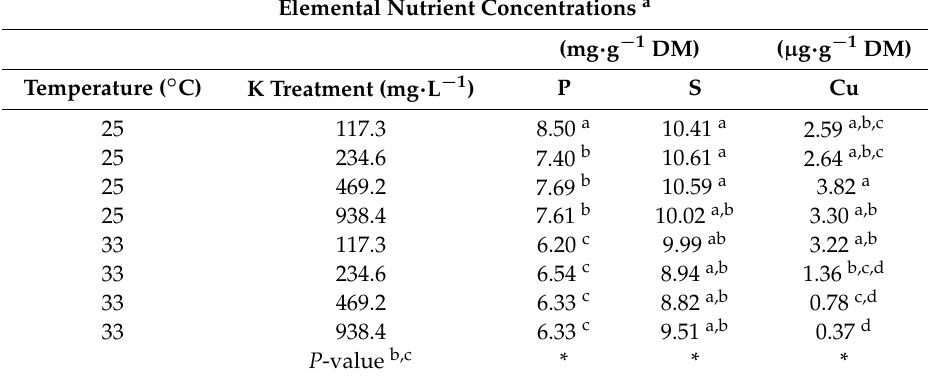
Table 3. The effect of the interaction between temperature and treatment on elemental nutrient concentrations of growth chamber red ‘Lollo’